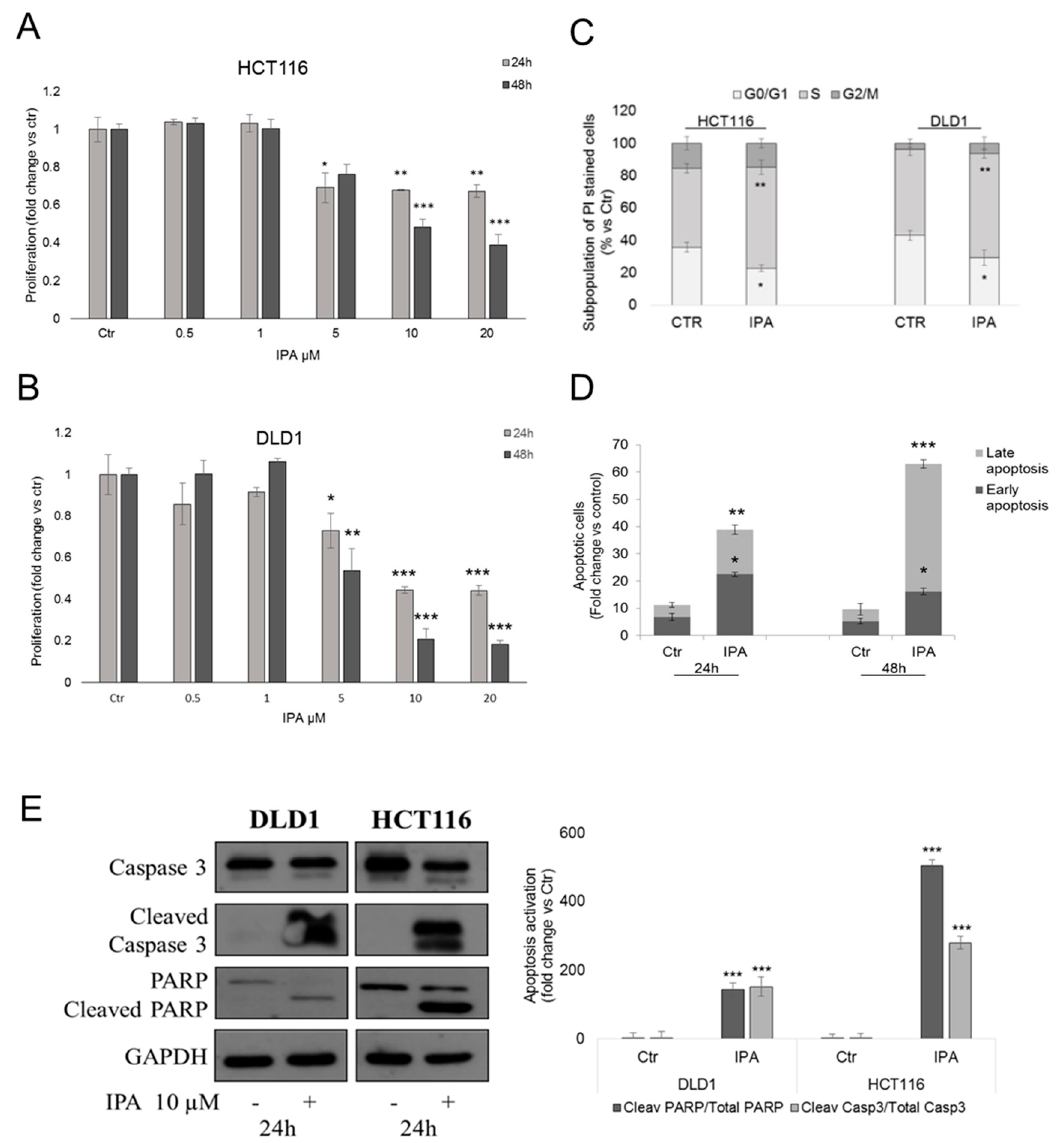
Figure 1. Effect of IPA on CRC cells in vitro. BrdU incorporation assay in HCT116 ( A ) and DLD1 ( B ) cells treated with indicated concentrations of IPA, for 24 h or 48 h. ( C ) Cell cycle analysis of HCT116 and DLD1 cells treated with IPA for 24 h and stained with PI. ( D ) Cytofluorimetric apoptosis analysis of Annexin V-FITC/PI double-stained DLD1 cells treated with 10 µM IPA, for 24 h and 48 h. Data are expressed as mean ± standard deviation (SD) of five independent experiments in triplicate. * p < 0.05, ** p < 0.01, *** p < 0.005 versus (vs.) control. ( E ) Representative western blot and densitometry analysis of apoptotic pathway activation in DLD1 and HCT116 cells. GAPDH was used as loading control. Data are expressed as mean ± SD of three independent experiments. *** p < 0.005 vs. control.